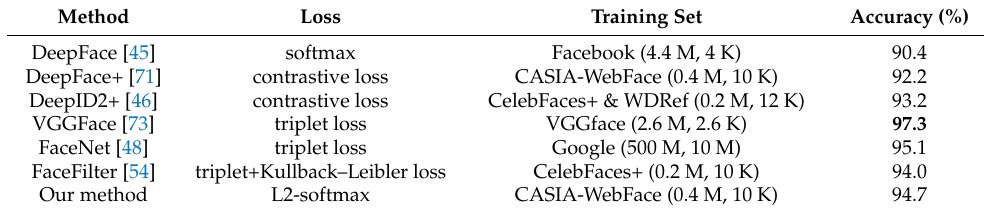
Table 13. Face recognition of different methods on the YTF dataset.